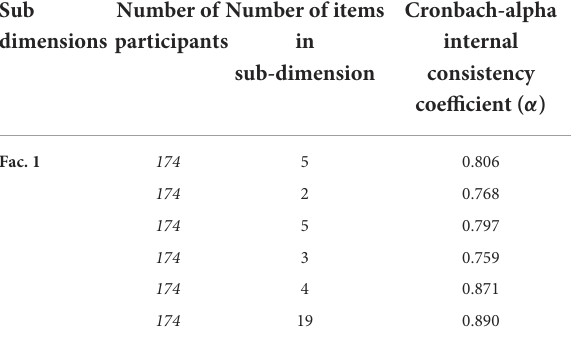
TABLE 4 Cronbach-alpha reliability analysis findings.